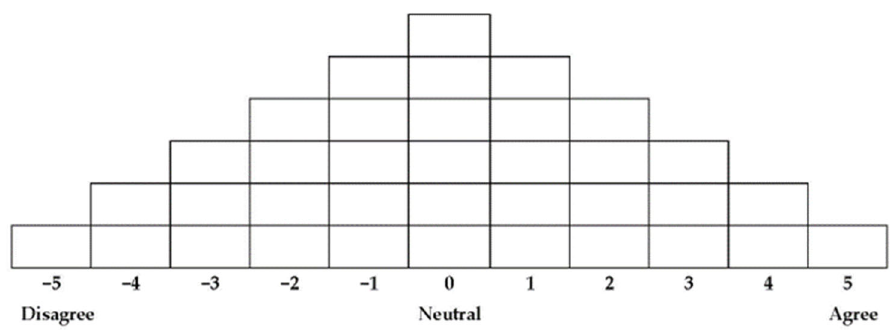
Figure 1. Q sample classification table.